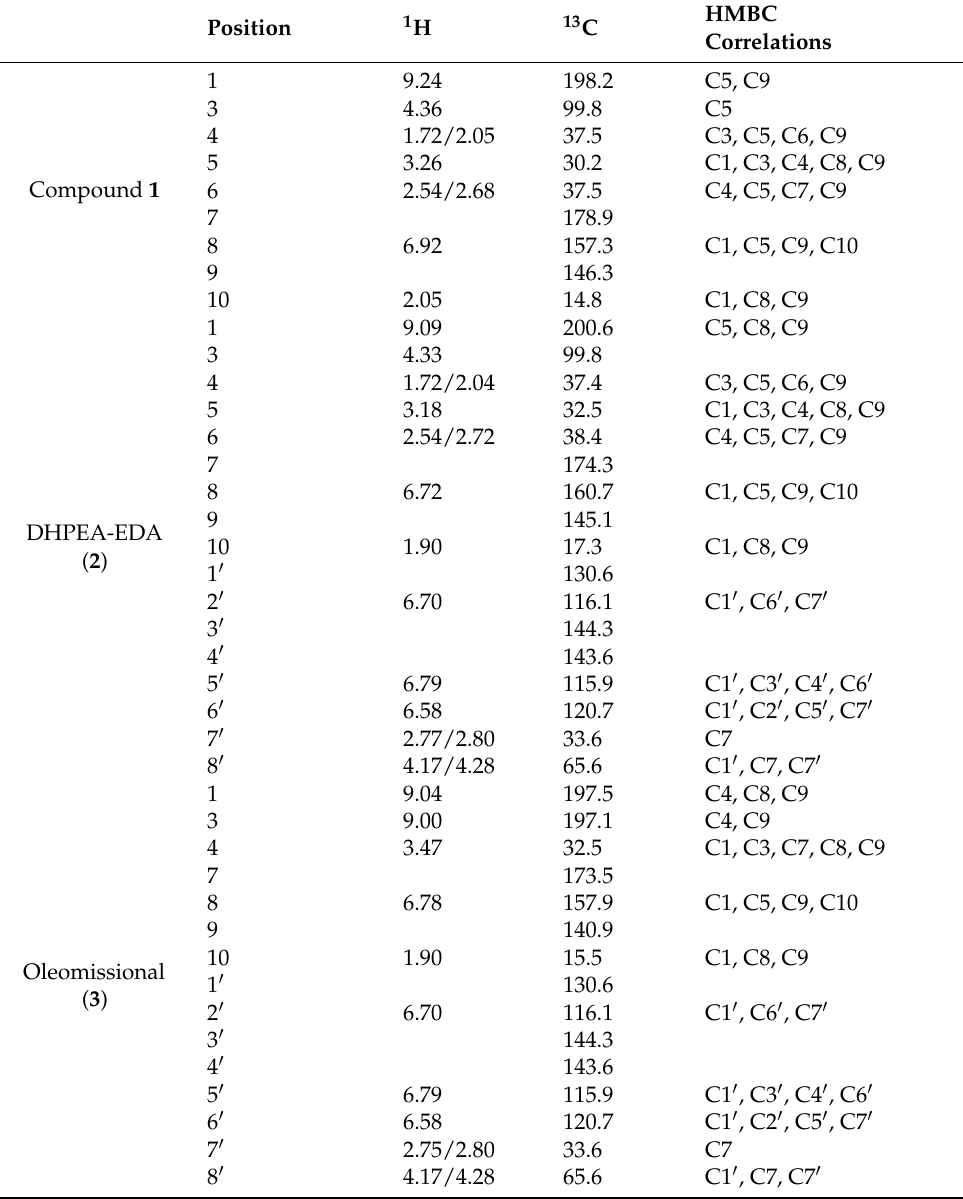
Figure 7. Compounds 1 – 4 identified in the extracts and responsible for the differentiation of the samples. Table 2. NMR data of the compounds identified in the extracts acquired at 300 MHz in 1:1 CD 3 OD: phosphate buffer in D 2 O. Position 1 H 13 C